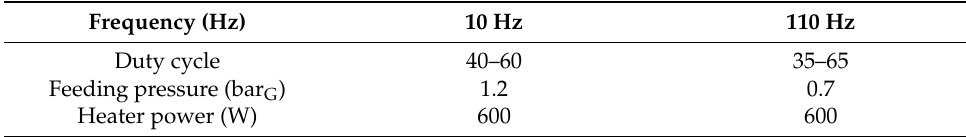
Table 2. EWG injection